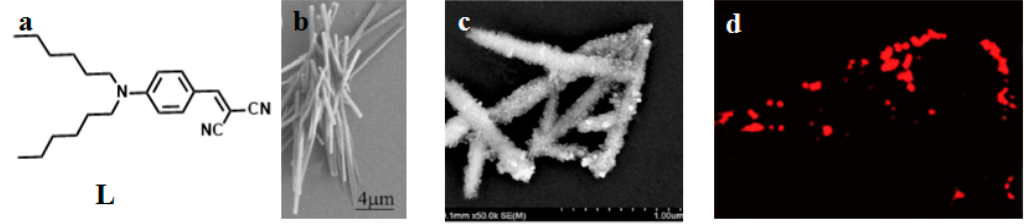
Figure 10. ( a ) Schematic representation of L; ( b ) SEM (Scanning electron microscope) micrograph of L